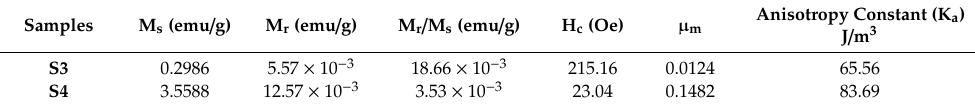
Table 3. The magnetic properties (M s, M r, M r / M s, K a and H c ) of the S3 and S4 samples.